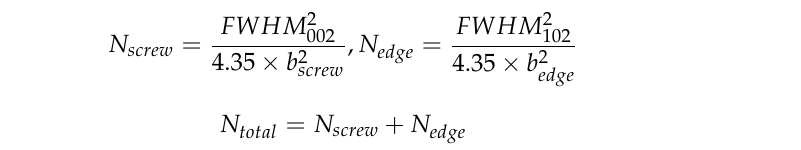
Figure 1. Cross-sections of the GaN on QST, with L G , L DS , and W G being 1, 4, and 50 µm, respectively.